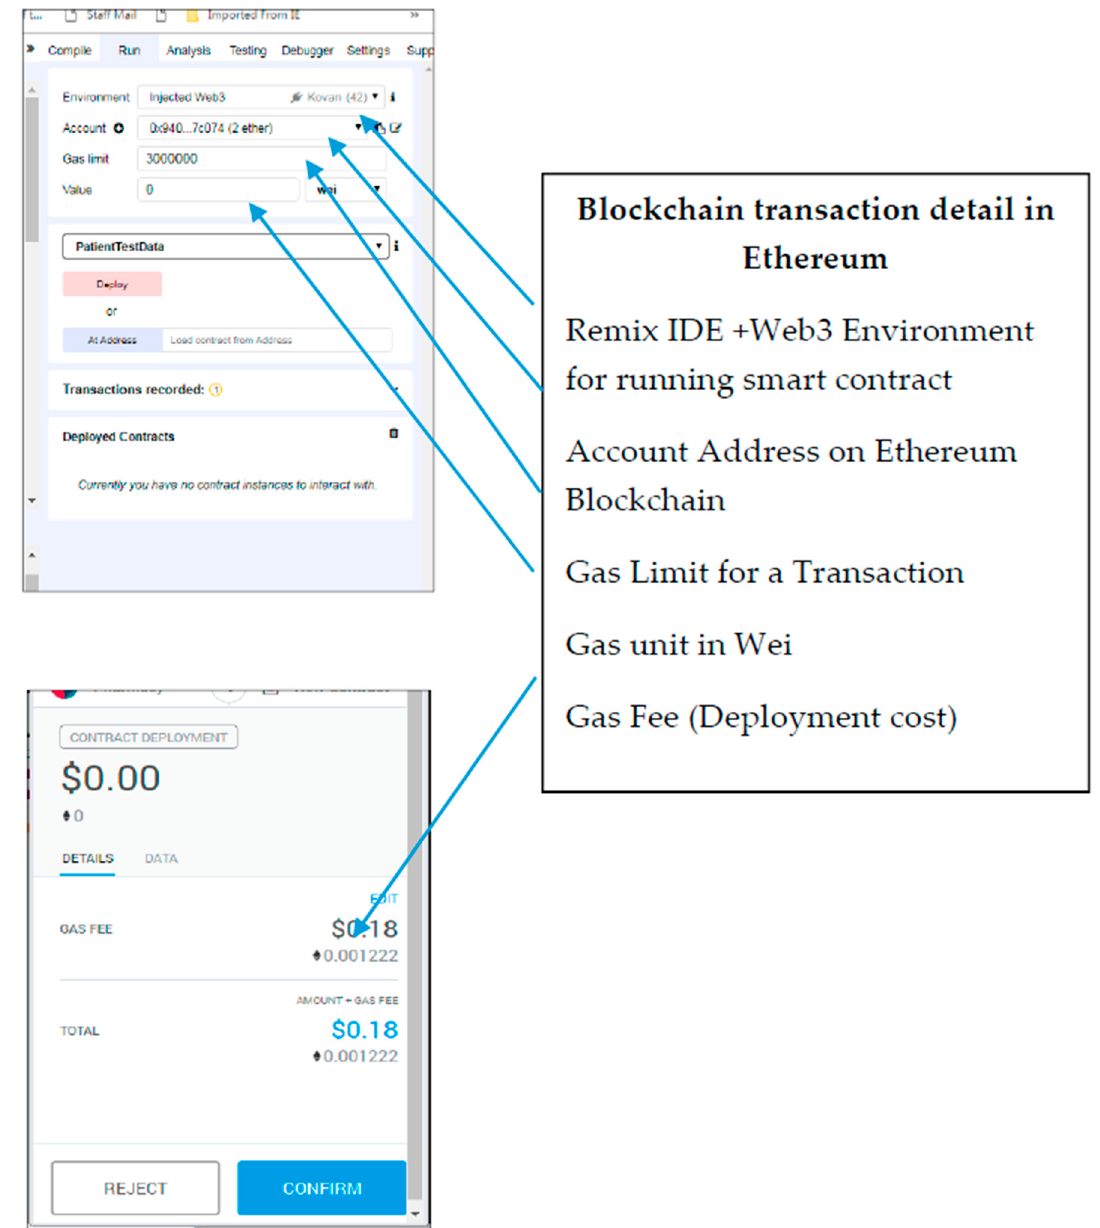
Figure 10. Metamask extension for calculating smart contract cost.